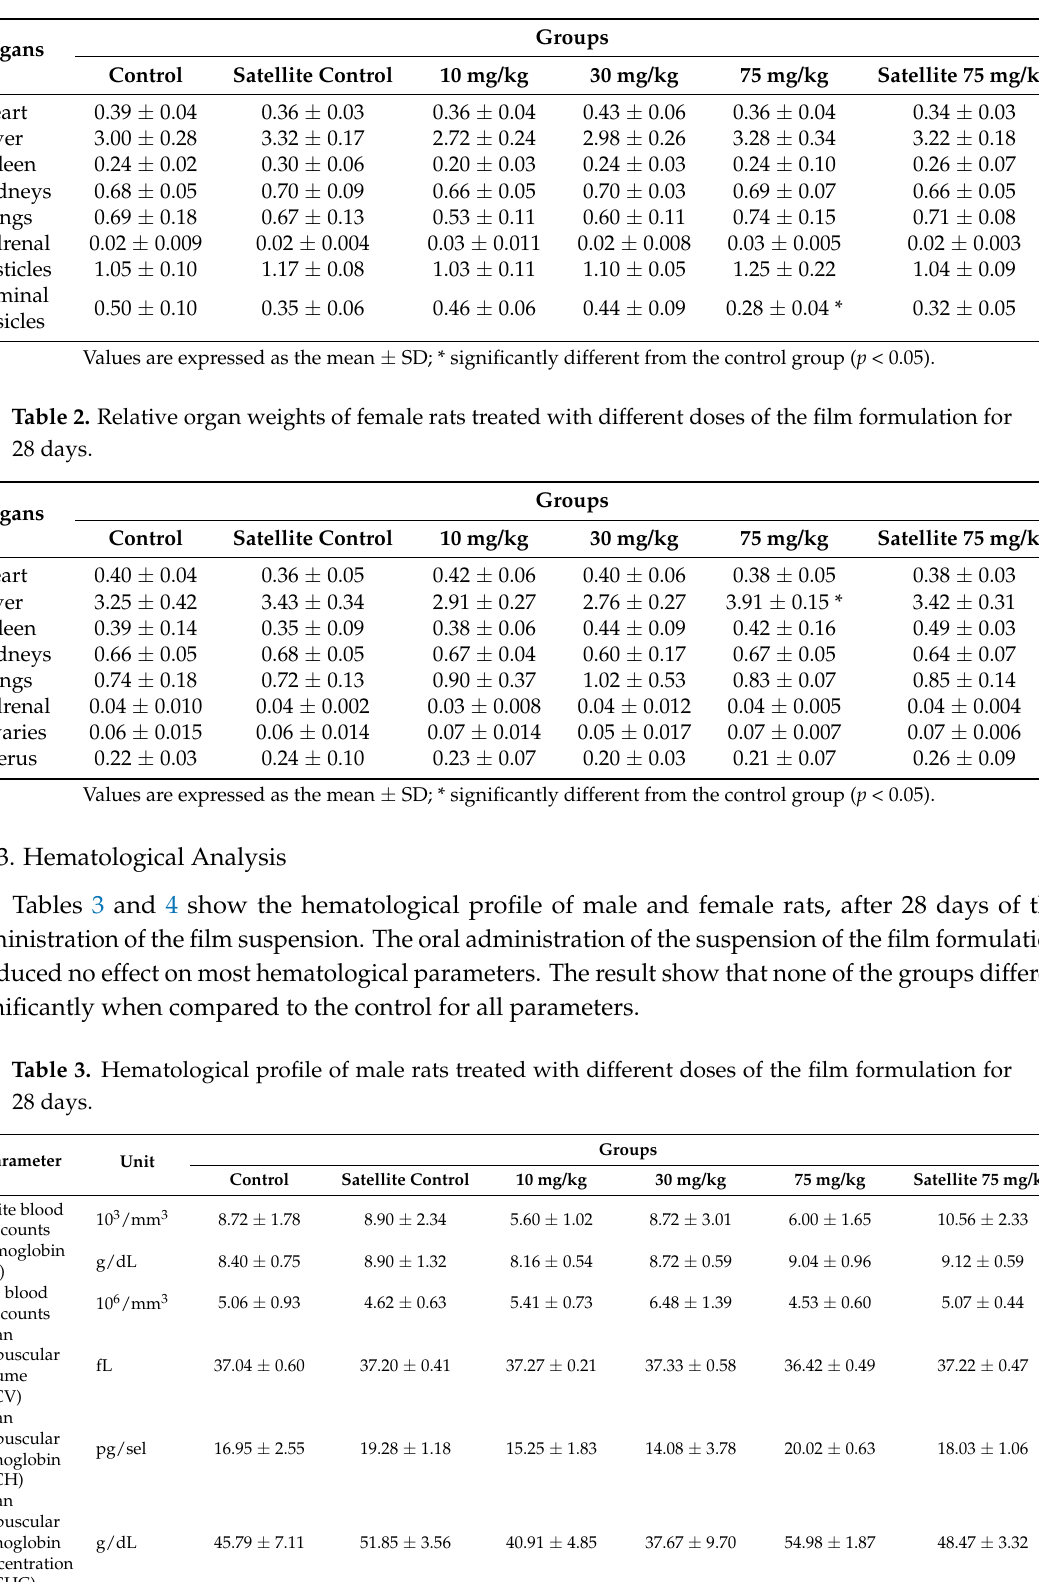
Table 1. Relative organ weights of male rats treated with different doses of the film formulation for 28 days.